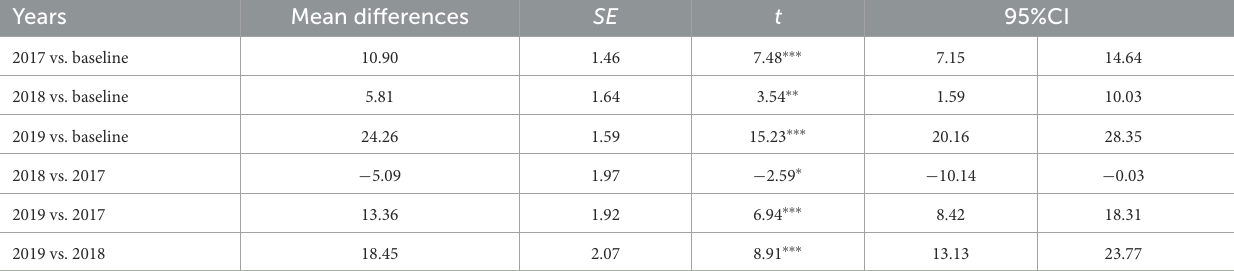
TABLE 7 Multiple comparisons: mean differences and confidence intervals for 1,000m run across mean baseline (2013–2016), 2017, 2018, and